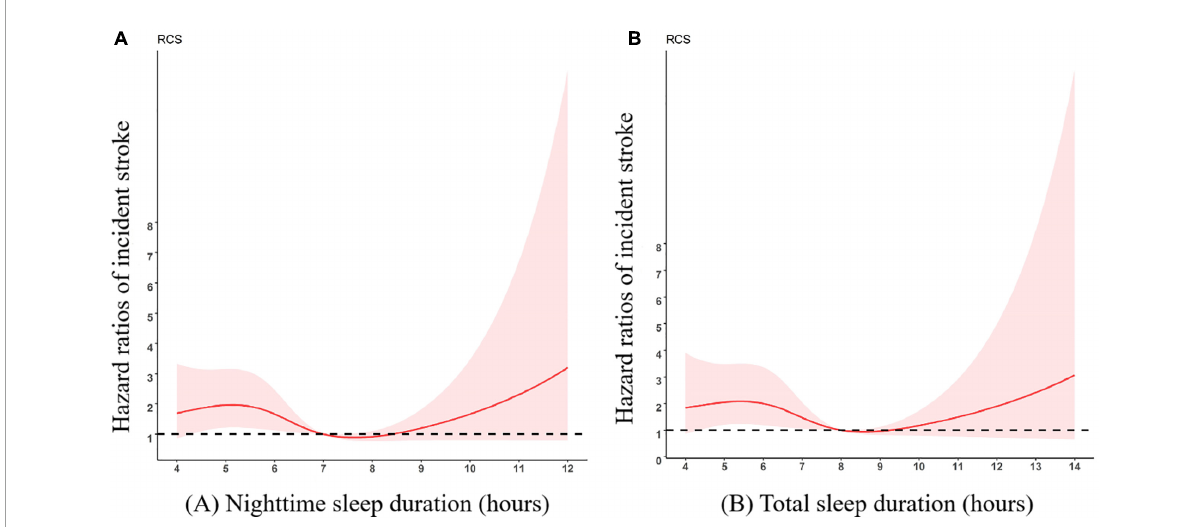
FIGURE2 Multivariate-adjusted spline curves for associations of sleep duration with incident stroke. The curves demonstrate that participants with short nighttime sleep duration (A) and total sleep duration (B) had a higher risk of stroke. (A) Nighttime sleep duration; (B) Total sleep duration. Adjusted for age, gender, educational level, marital status, area of residence, and behaviors including smoking, drinking, and physical activity. The reference group was 7 h/night for nighttime sleep duration and 8 h/day for total sleep